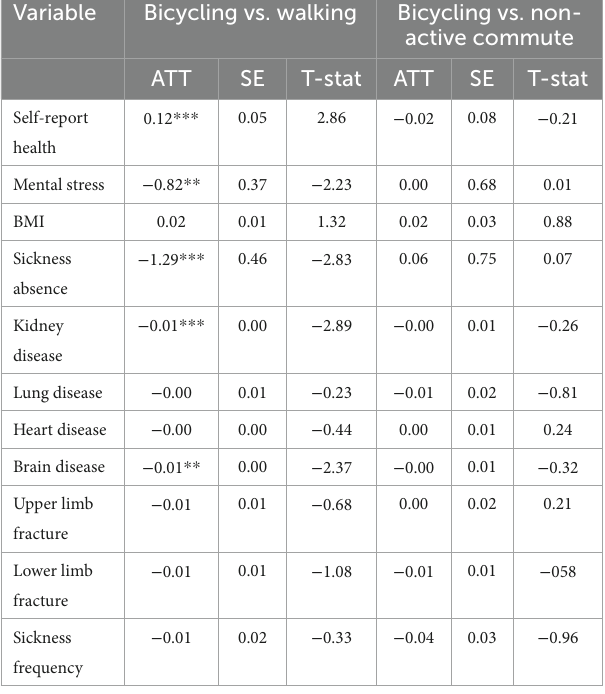
TABLE 5 Effects of bicycling on adolescent health (bicycling vs. walking; bicycling vs. non-active commute). Variable Bicycling vs.